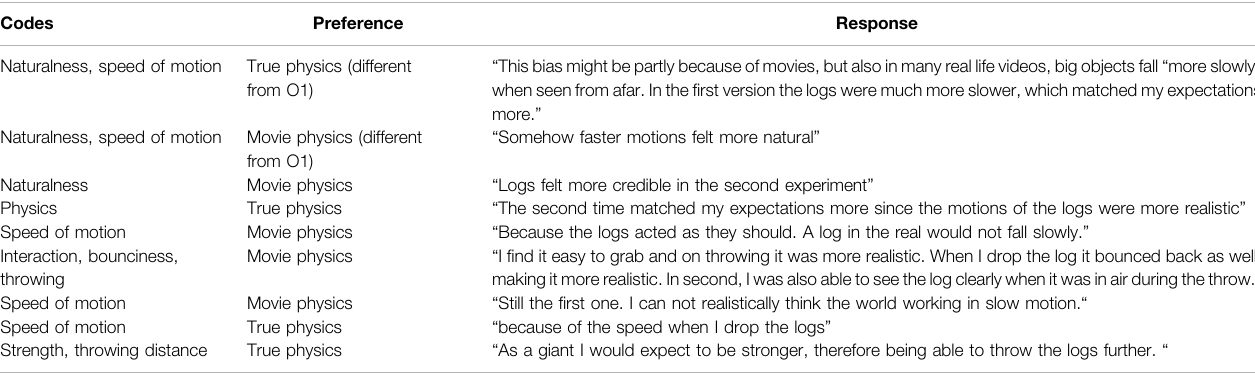
TABLE 5 | Examples of O2 responses (justi fi cation to expectations ) in Study 2 Codes